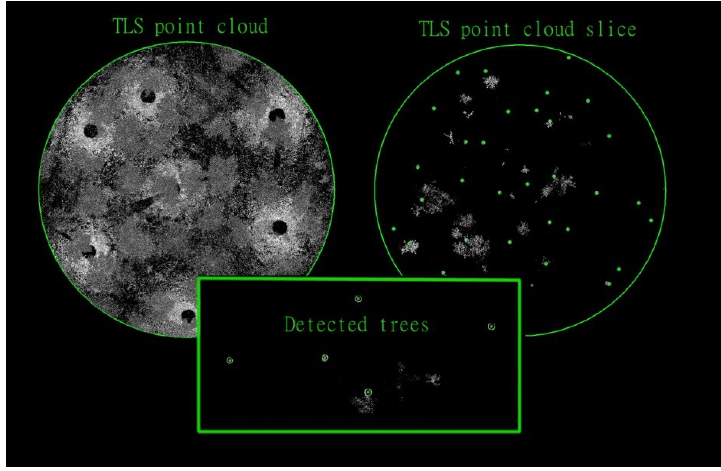
Figure 2. Example of the tree-detection method from the TLS point